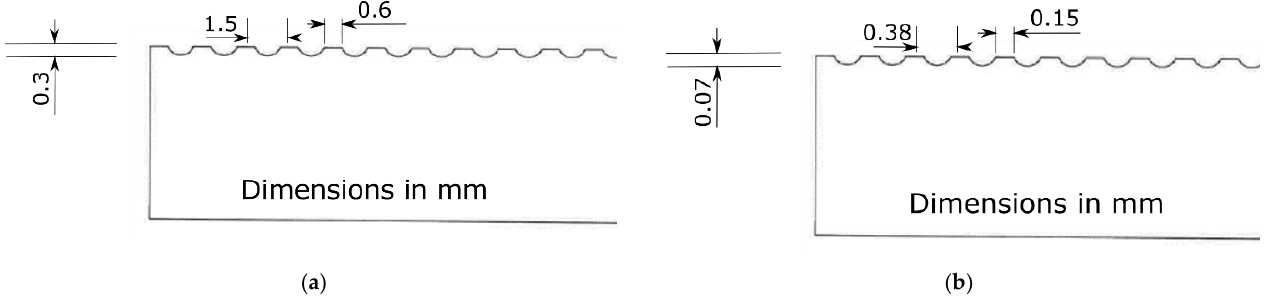
Figure 2. Profile of the back of the knives used to produce micro-structured surfaces. ( a ) Coarse structure with a structure easily visible with naked eye. ( b ) Fine structure visible after application of contrast enhancer (graphite, for example). All dimensions are shown in millimetres. Table 1. Tested surfacing methods.